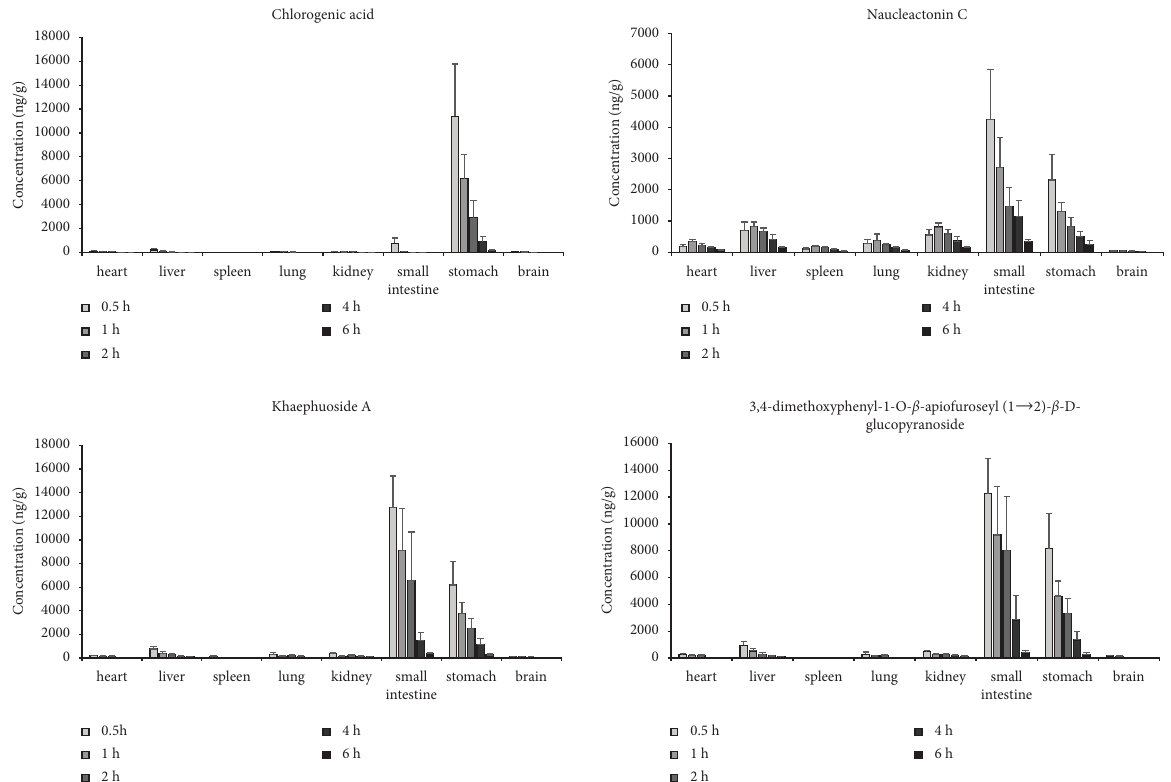
Figure 4: Mean concentration of four analytes in the heart, liver, spleen, lung, kidney, small intestine, stomach, and brain at 0.5, 1, 2, 4, and 6h after oral administration of Nauclea ofcinalis extracts at a dose of 2